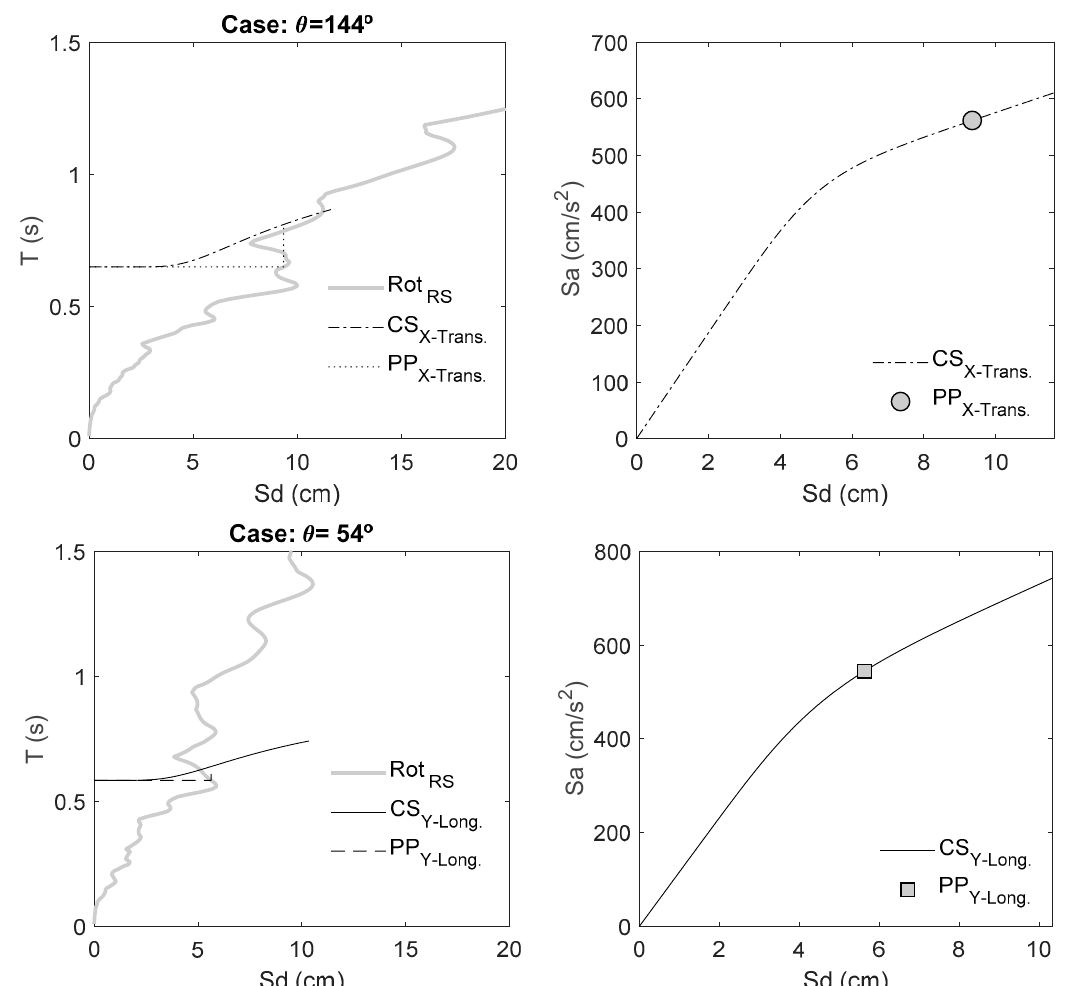
Figure 17. Linear-equivalent approximation to estimate the performance point of X Long. (144° case) and Y Long. (54° case) axes.